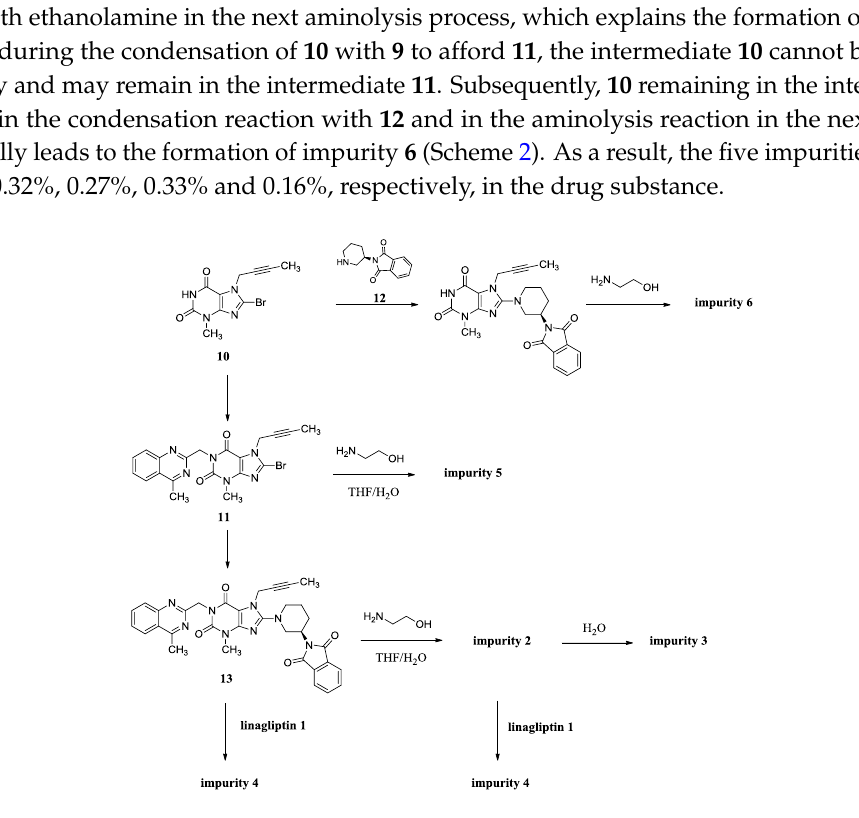
Figure 2. Typical HPLC chromatogram of linagliptin with impurities.